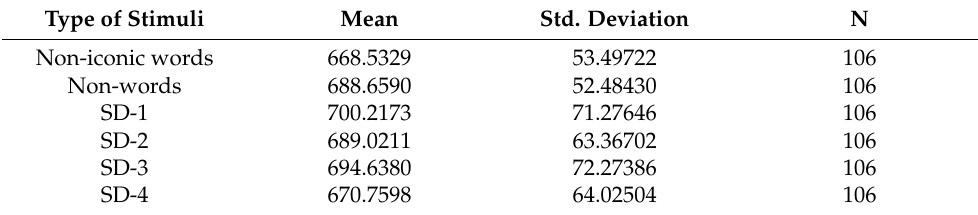
Table 5. Mean recognition time (in ms) and standard deviation for different stimuli types.